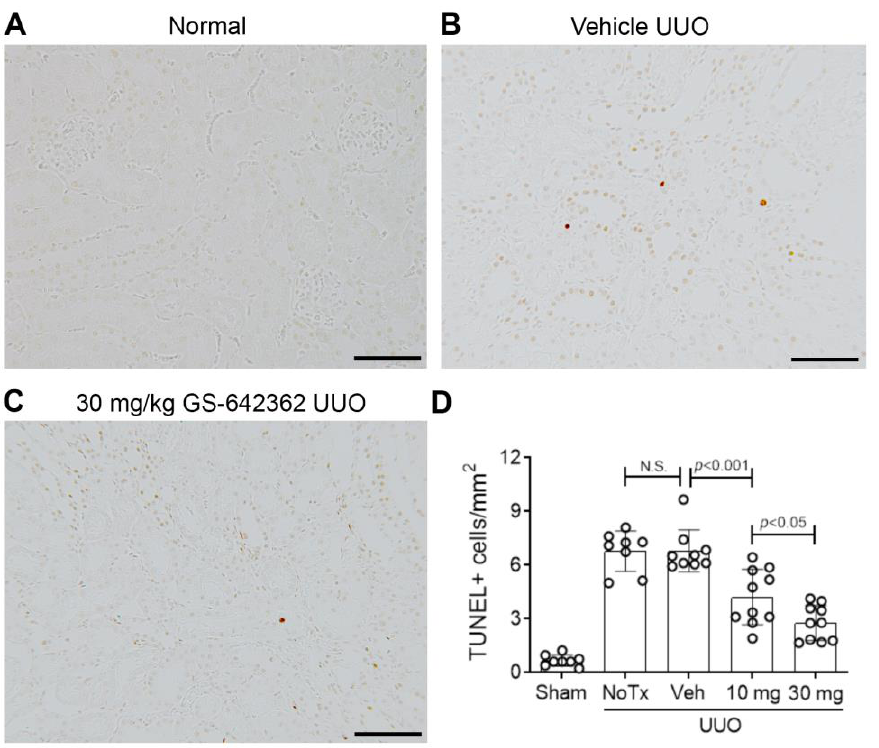
Figure 6. Cell death in the day 7 unilateral ureteric obstruction (UUO) model (n = 8 to